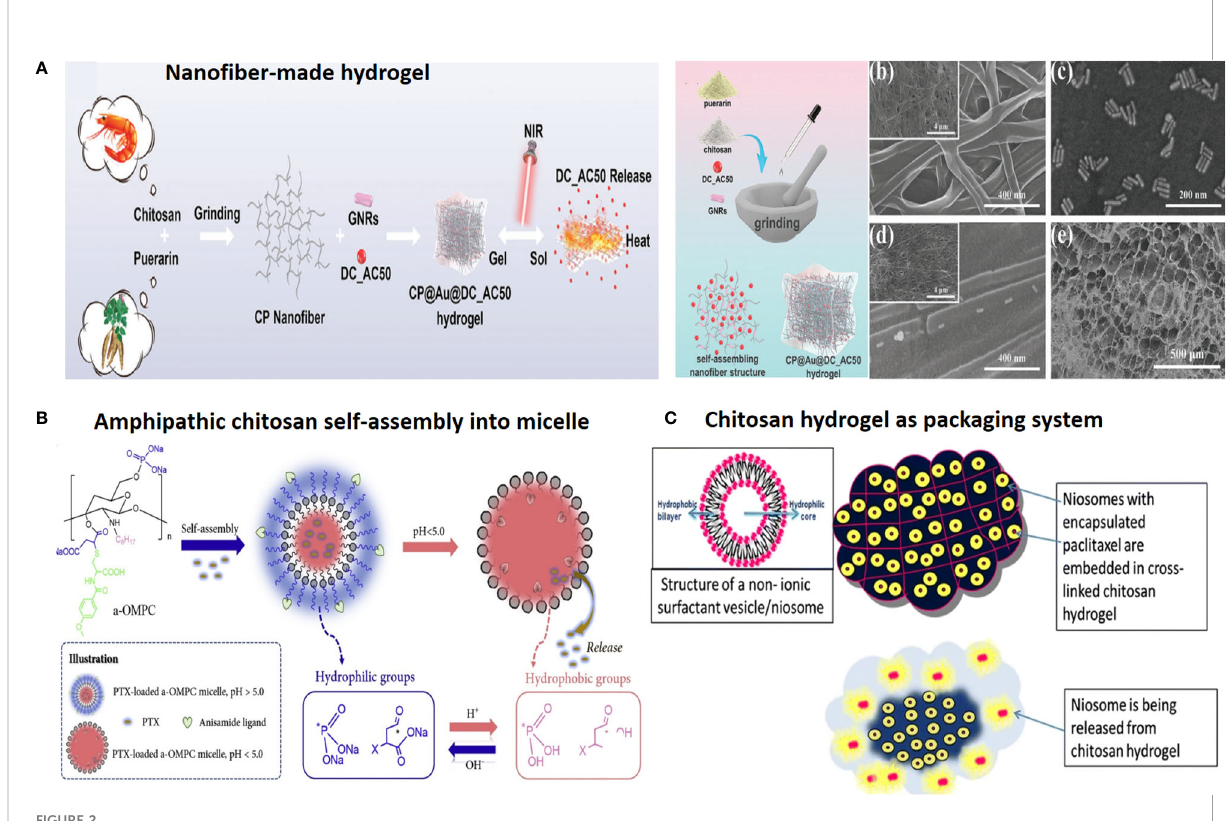
FIGURE 2 Chitosan-based drug delivery systems for cancer targeting. (A) Nano fi ber-based chitosan hydrogel as injectable drug depot. Reprinted from (65) under Creative Commons Attribution License 4.0, Copyright (2021) Wiley ‐ VCH GmbH. (B) Amphipathic chitosan can self-assemble into vesicular core – shell particles. Reprinted with permission from (66), Copyright (2021) Elsevier. (C) Chitosan hydrogel as a packaging system for other NPs (niosome in hydrogel). Reprinted from (23) under Creative Commons Attribution License 4.0, Copyright (2020) Springer